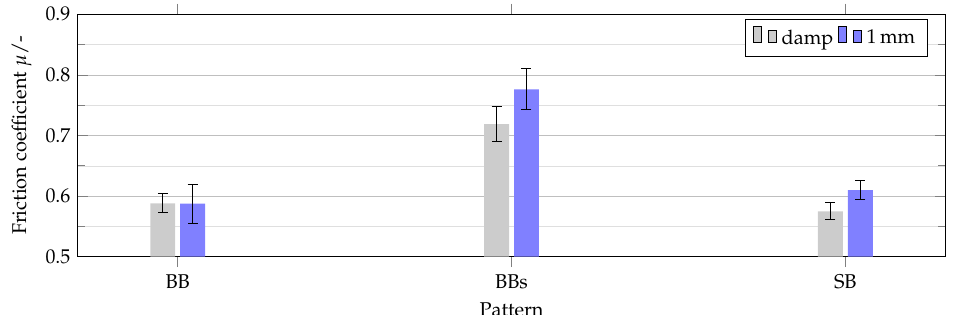
Figure 19. Comparison wet and 1mm water height on asphalt at 120kmh − 1 .